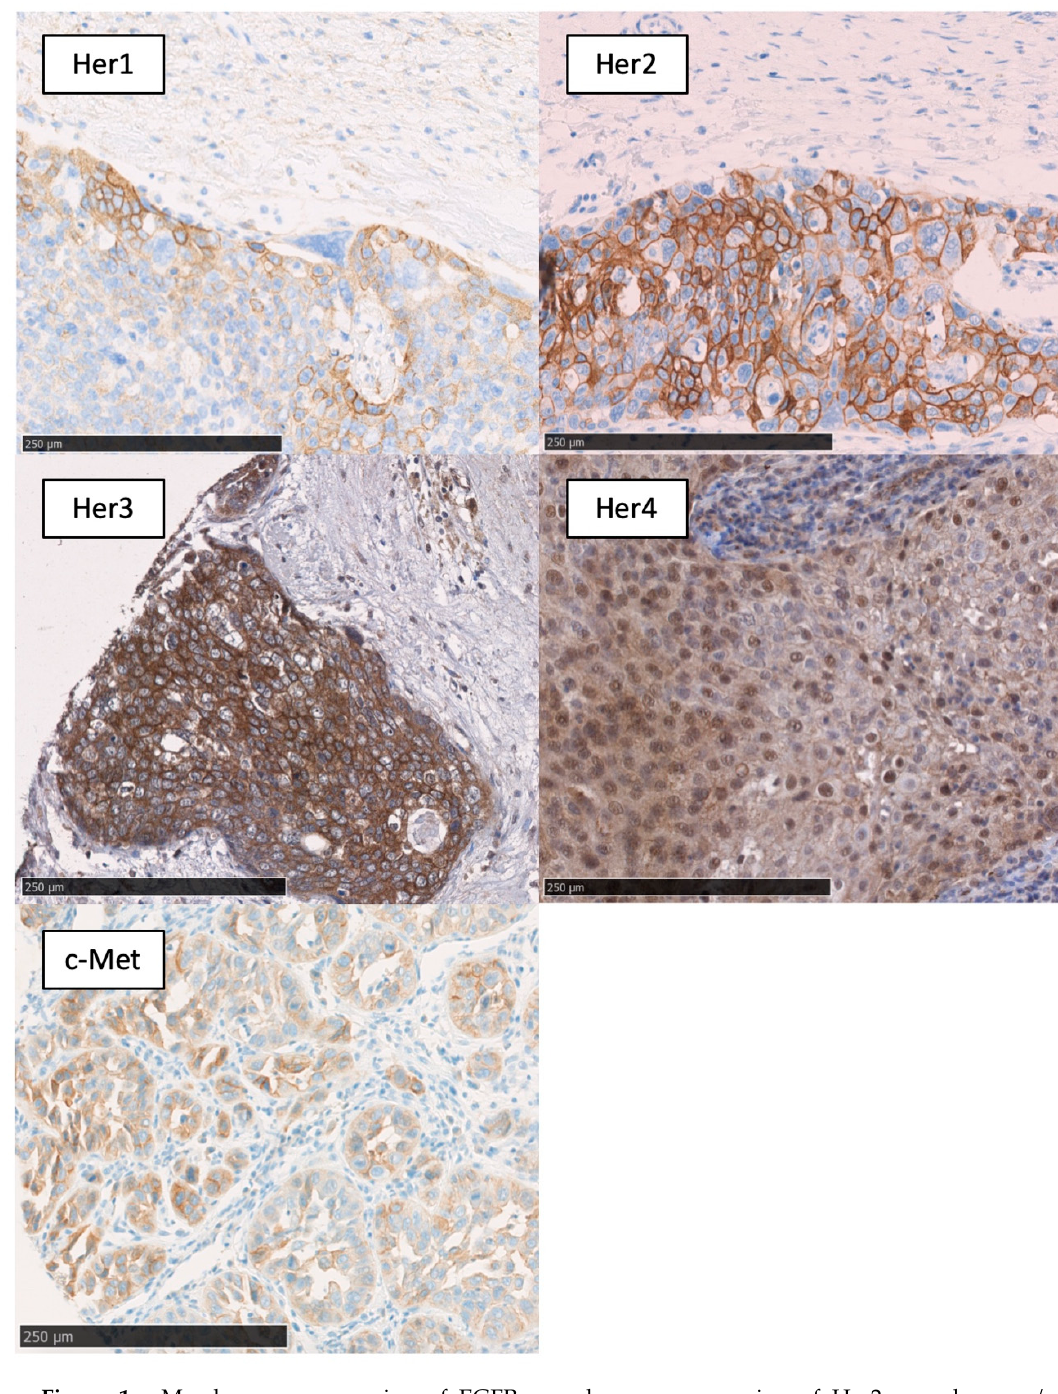
Figure 1. Membranous expression of EGFR; membranous expression of Her2; membranous / cytoplasmatic expression of Her3; membranous / cytoplasmatic / nuclear expression of Her4; and membranous ex-pression of c-Met. Black bar, 250 µm.